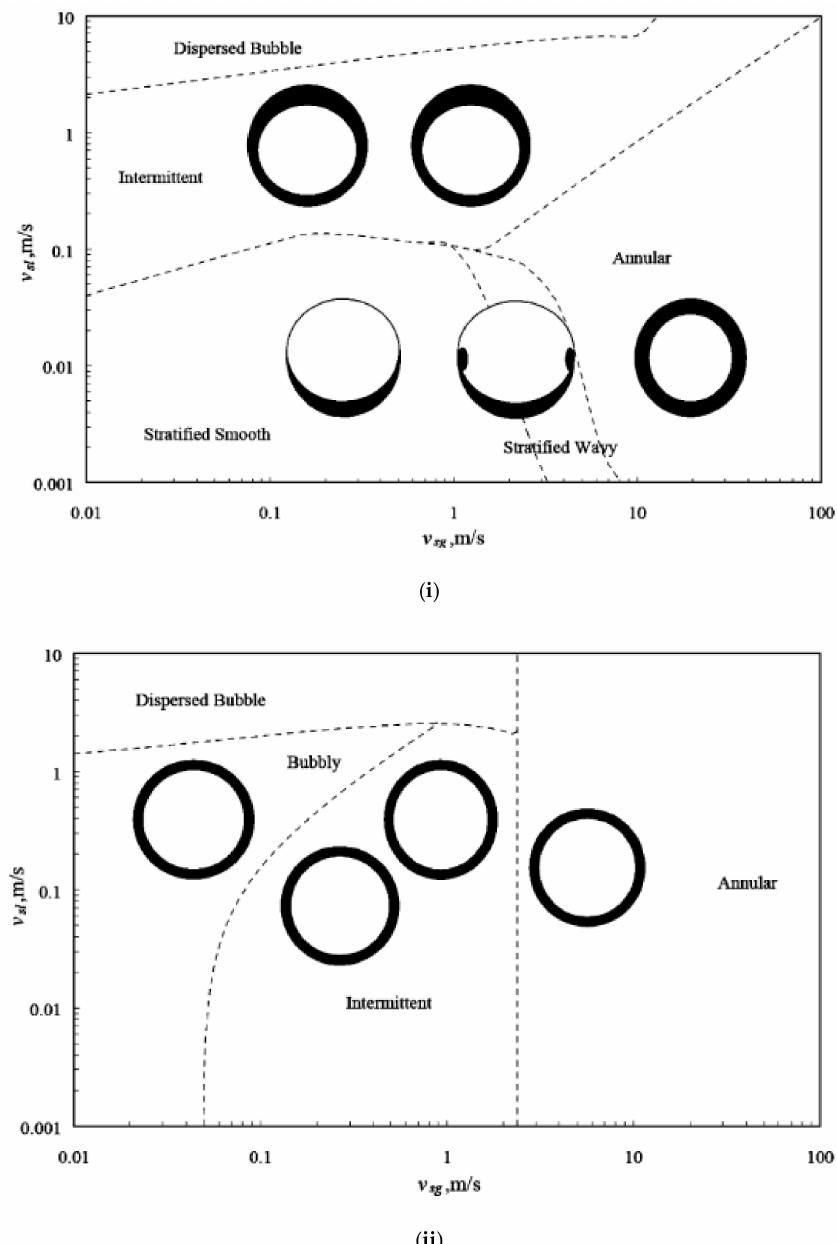
Figure 3. Wax deposition distribution. ( i ) Wax deposition distribution (in shaded area) for horizontal flow. ( ii ) Wax deposition distribution (in shaded area) for vertical